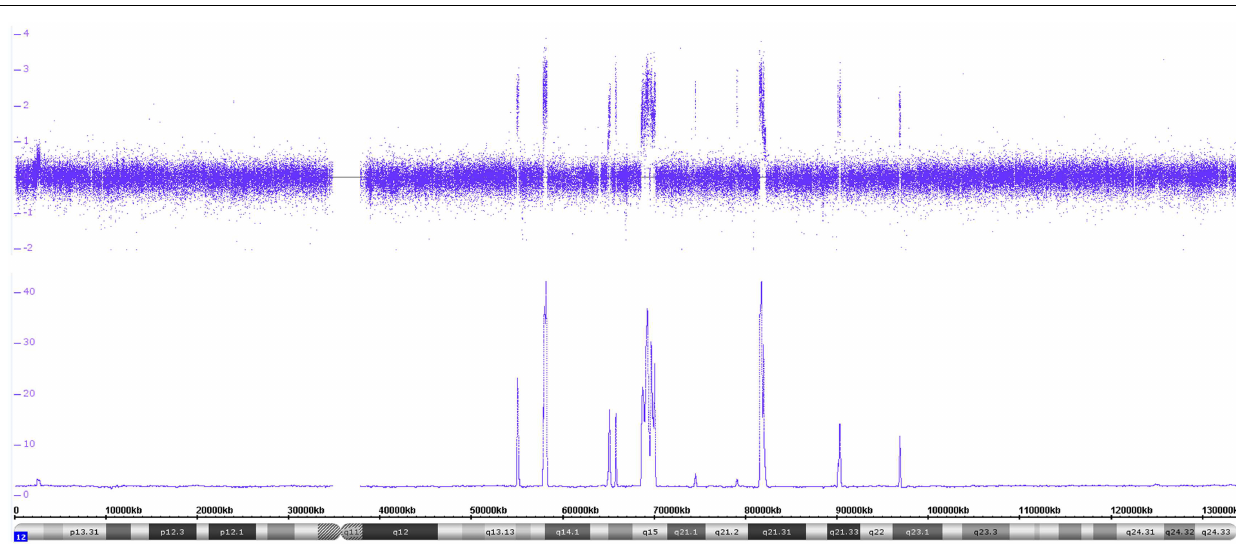
FIGURE 5 |The copy number data disclose a high number of amplicons on the long arm of chromosome 12 .The log 2 copy number track and the smooth signal track show a number of copy number peaks ranging from ~10